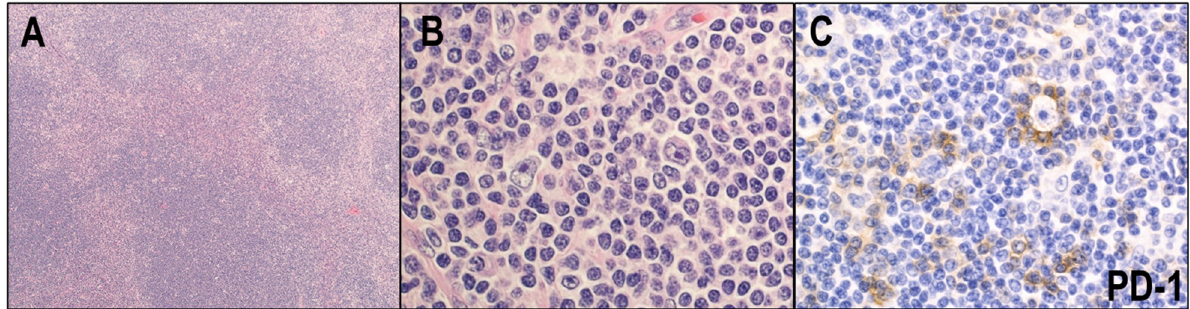
Figure 4. Lymphocyte-rich classic Hodgkin lymphoma (LRCHL). ( A ) LRCHL commonly shows a nodular growth pattern, which may contain germinal centers (HE × 40). ( B ) The nodules are com- posed of HRS cells and small lymphocytes without polymorphic cell composition (HE × 400). ( C ) HRS cells are frequently characterized by rosetting of PD1-positive T cells (×400).